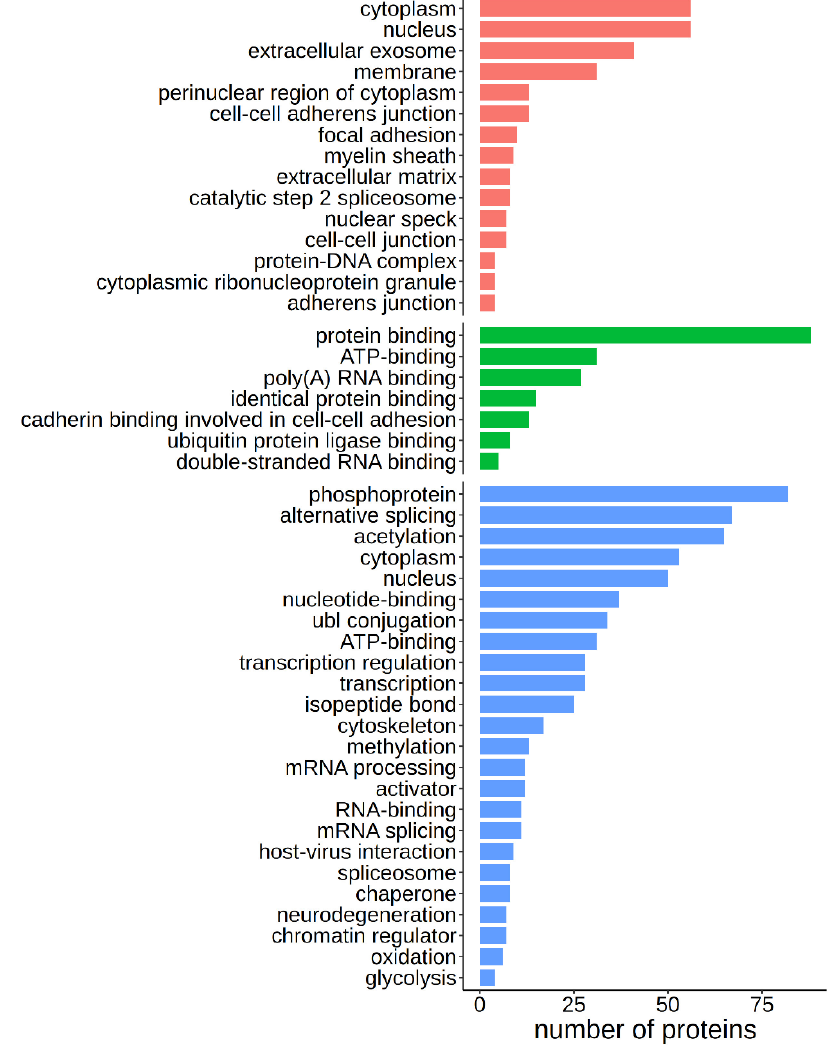
Figure 4. Pathway enrichment of the 107 highly conserved caspase targets. Pathway analysis using the DAVID free online software, with default parameters and an EASE threshold of < 0.05 was followed by annotation using two databases: Gene Ontology [32] and Uniprot [22]. Proteins were classified in terms of Gene Ontology—Cellular Component ( red ), Gene Ontology—Molecular Function ( green ), and Uniprot Keywords ( blue ). The p -value for annotation selection was adjusted by Benjamini–Hochberg correction. Annotations with a corrected p -value < 0.05 were considered significant and were presented in the plots.